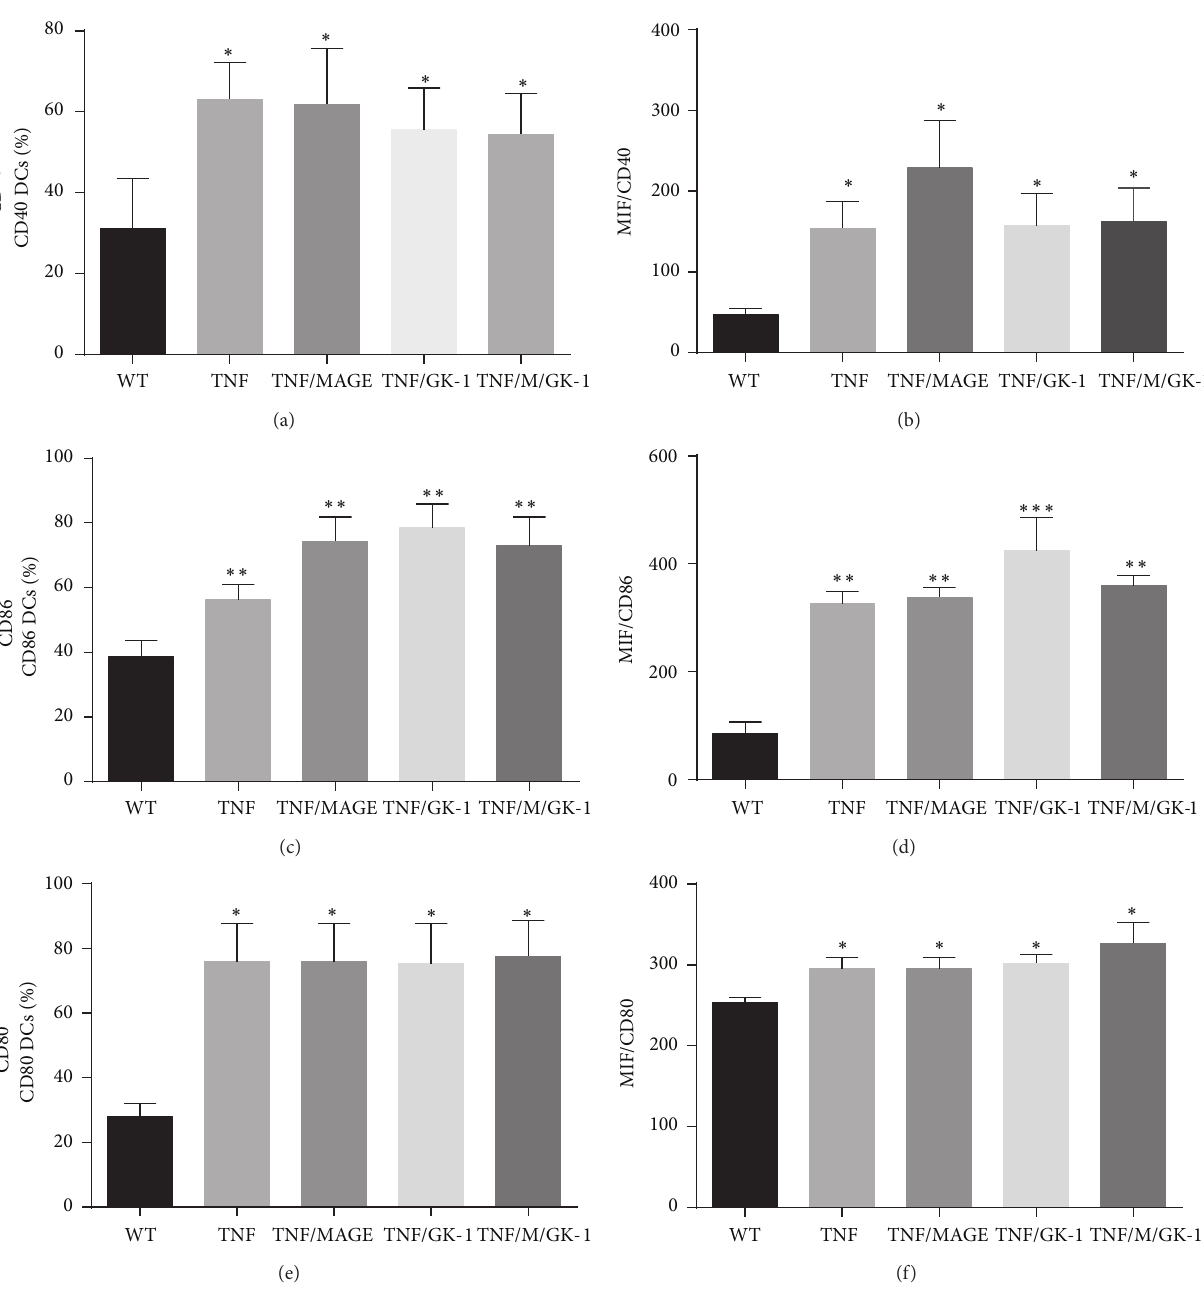
Figure 2: Effect of GK-1 and/or MAGE-AX with TNF 𝛼 in the BMDCs phenotype . Treatment with MAGE-AX did not induce changes in the phenotype of BMDCs. (a) Percentage of CD40+ BMDCs. ∗ 𝑃 < 0.05 . (b) MFI of CD40 in BMDCs. ∗ 𝑃 < 0.05 . (c) Percentage of CD86+ BMDCs. ∗∗ 𝑃 < 0.001 . (d) MFI of CD86 in BMDCs. ∗∗ 𝑃 < 0.05 , ∗∗∗ 𝑃 < 0.001 . (e) Percentage of CD80+ BMDCs. ∗ 𝑃 < 0.05 . (f) MFI of CD80 in BMDCs. ∗ 𝑃 < 0.05 . Mean ± SEM 𝑛 ≥ 3